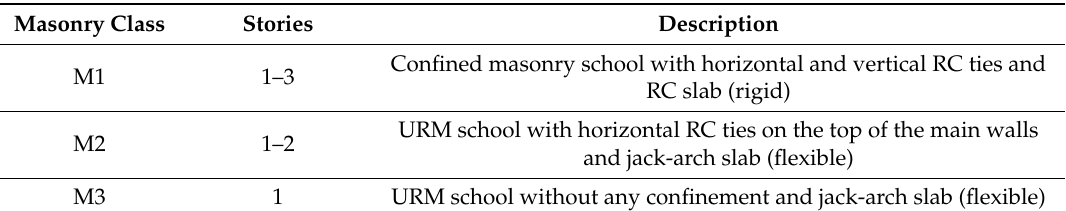
Table 9. Masonry typologies proposed by